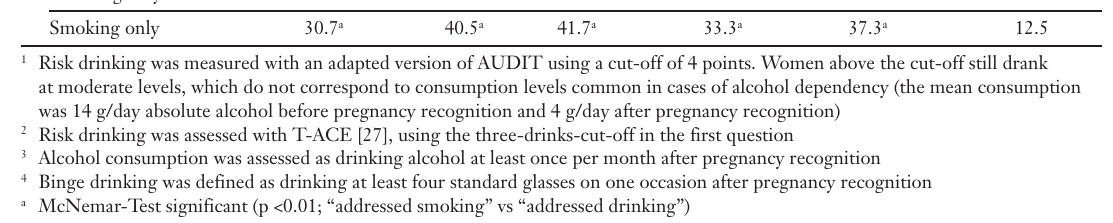
Table 2 Percentage of preg- nant women who were asked about drinking and smoking within different sub- samples of substance use habits after preg- nancy